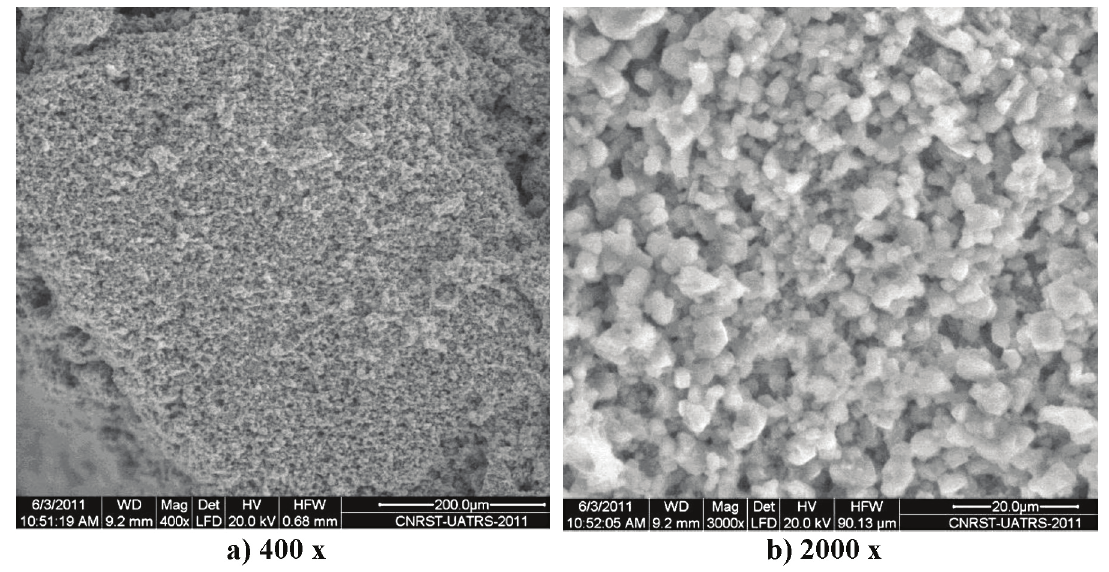
Fig. 3 – SEM photographs of CES adsorbent